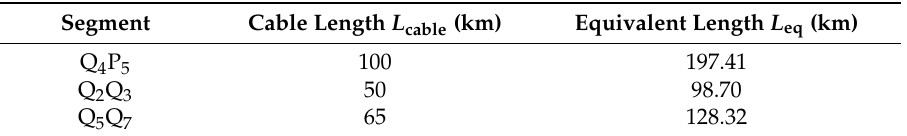
Table 2. Normalization for cables.